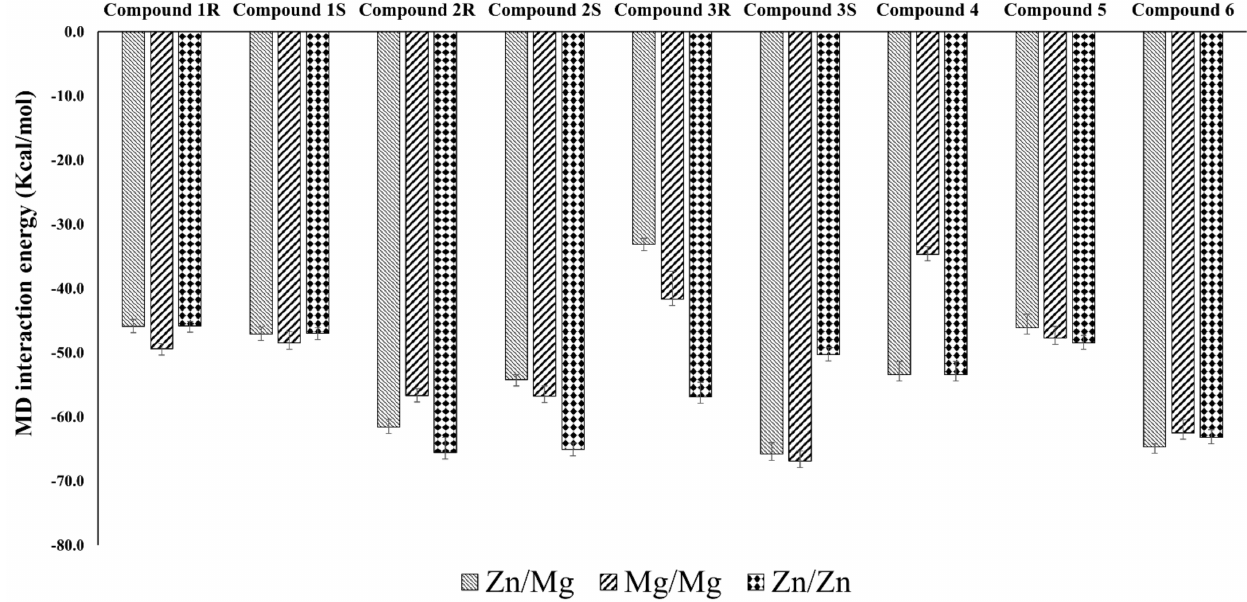
Figure 12. MD interaction energy was calculated for the compounds in PDE-9 (in Zn/Mg, Mg/Mg, and Zn/Zn).